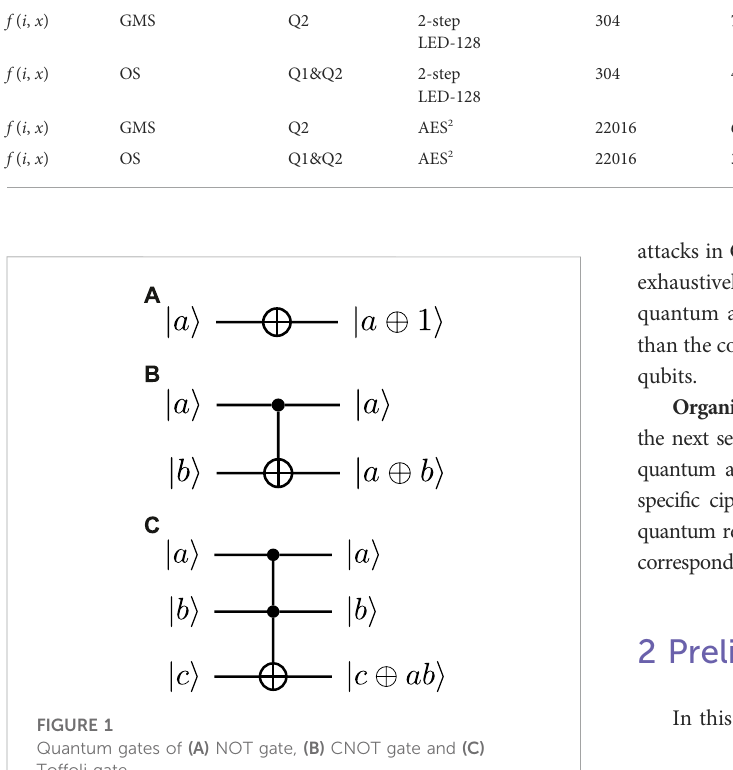
FIGURE 1 Quantum gates of (A) NOT gate, (B) CNOT gate and (C) Toffoli